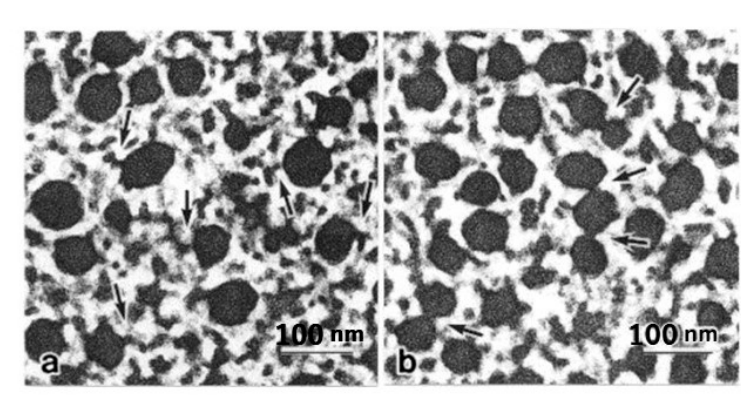
Figure 8. Cross-sections at higher magnification showing linkages between the thick and thin filaments (arrows) in the ABRM frozen during the actively contracting state ( a ), and interconnections between the thick filaments ( b ) in the ABRM frozen during the catch state. (Takahashi et al. [36]).